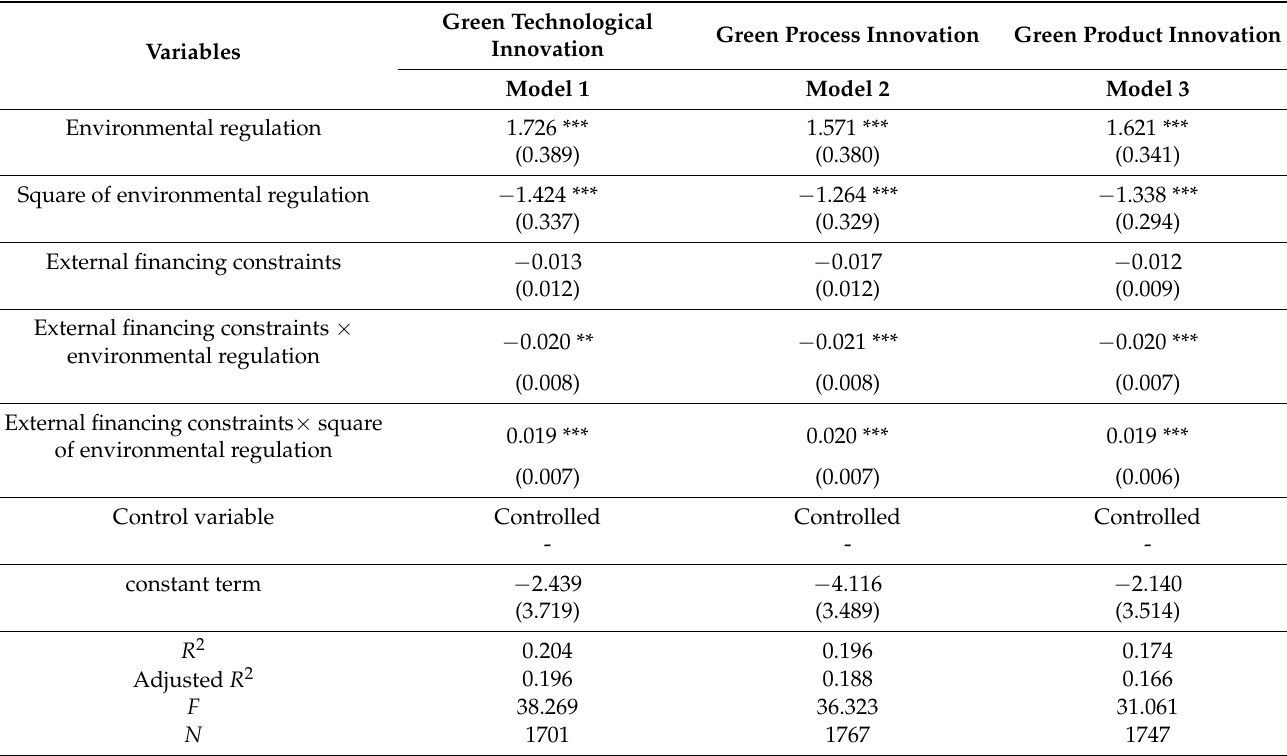
Table 5. Robustness test